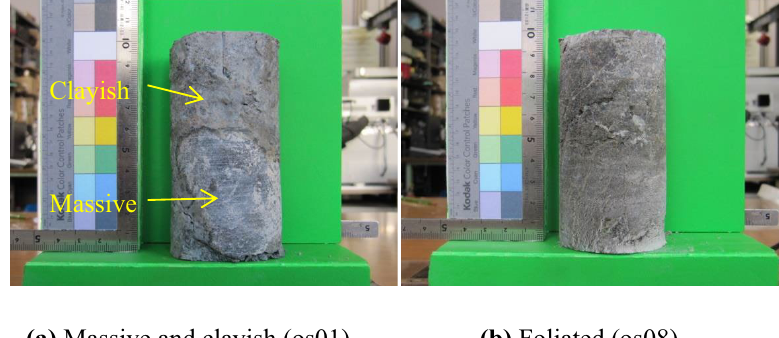
Fig. 6 Examples of the serpen- tinite specimens